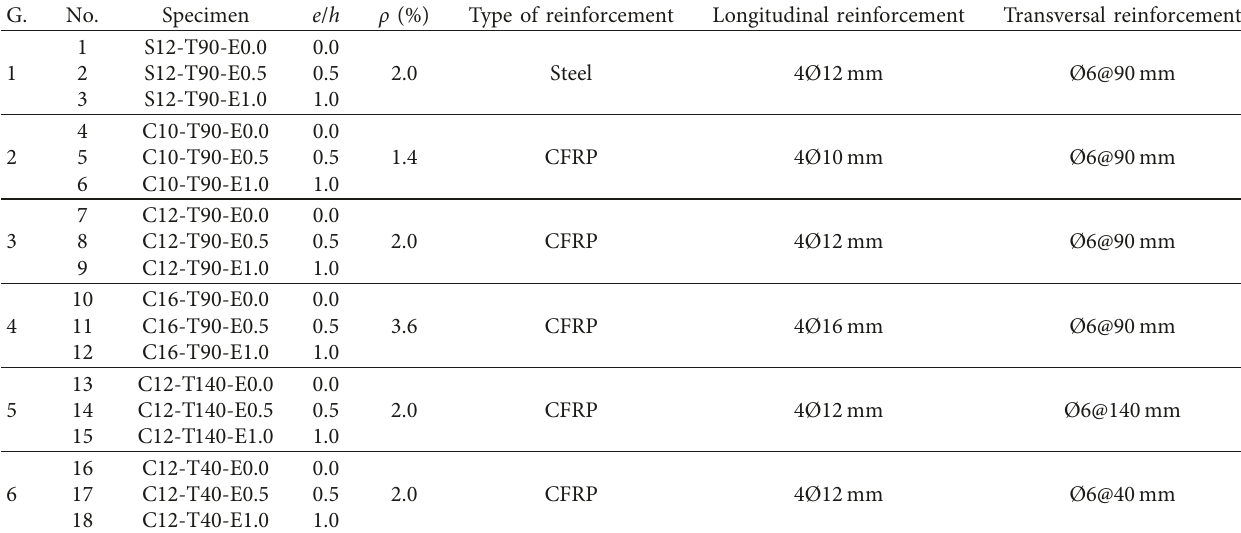
Table 1: Details of tested